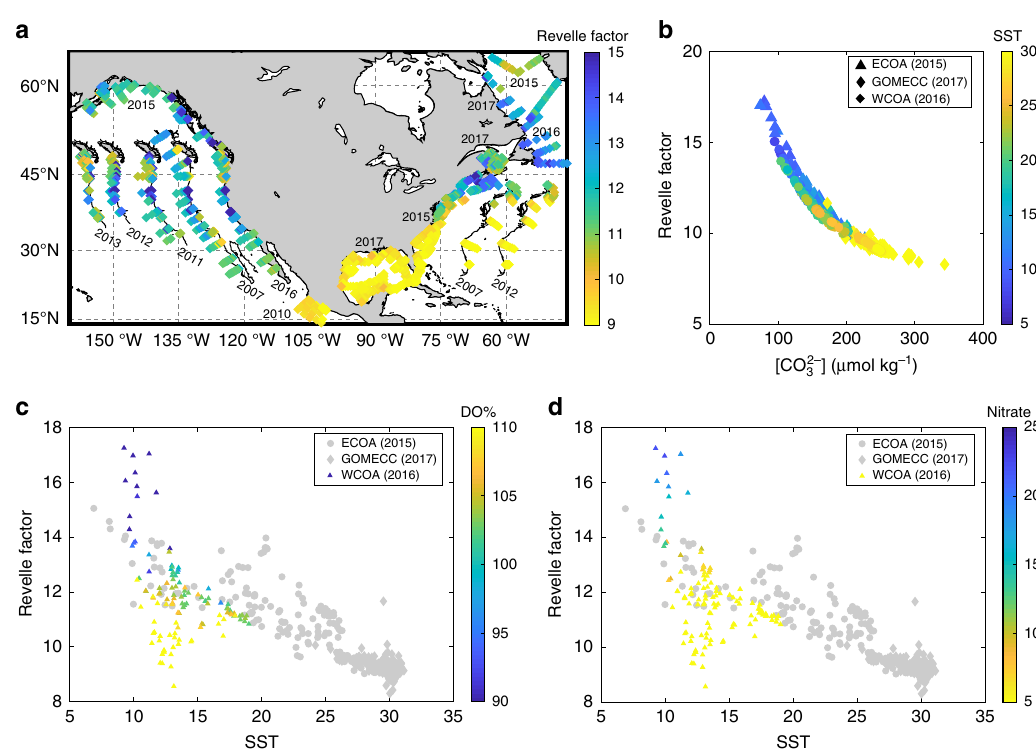
], and 3 ]. Spatial distribution of [ CO 2 (cid:1) ] is presented in Supplementary Fig. 4. In 3 3